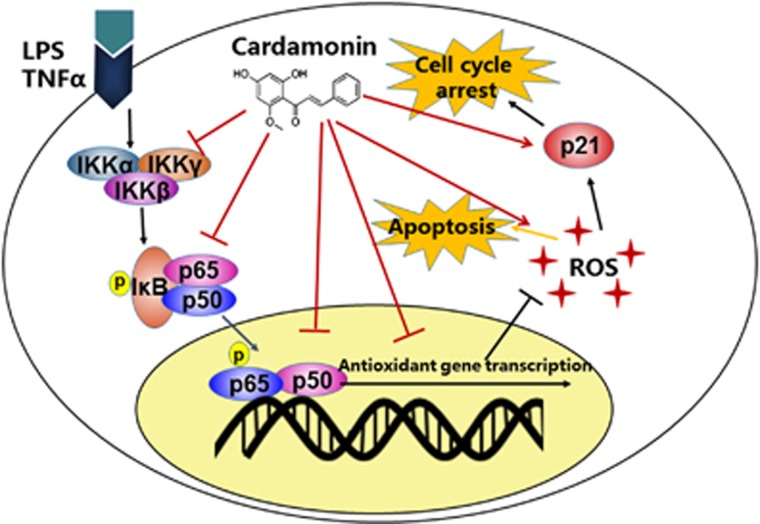
Illustration of possible molecular mechanism of cardamonin-induced inhibitory effect in NPC cells